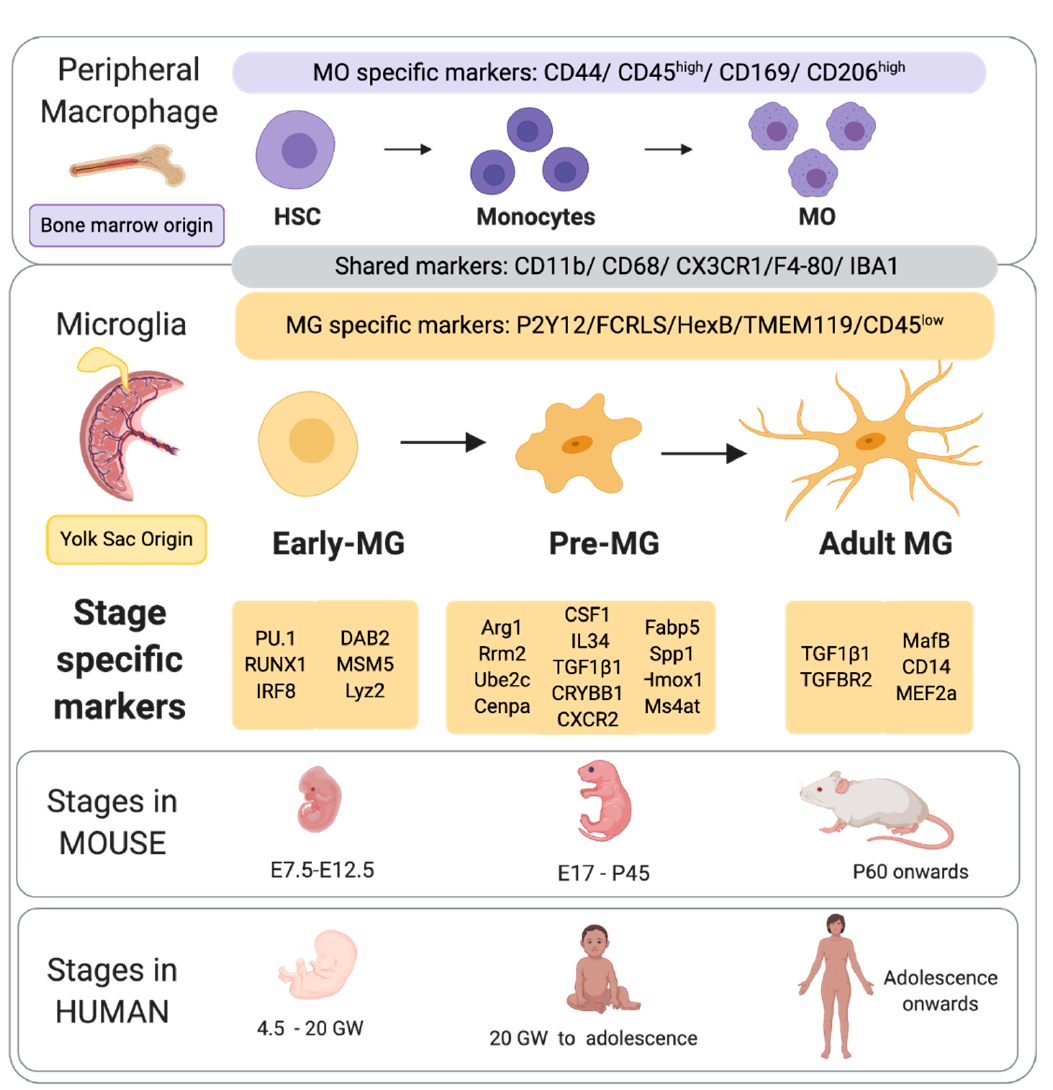
Figure 1. Outline of the origins or macrophage and microglia highlighting common and unique markers. Also, the stage specific markers as drawn and adapted from [35–38] and stages of maturation of microglia, their approximate timing in mouse and human [39,40]. Created with BioRen- der.com.